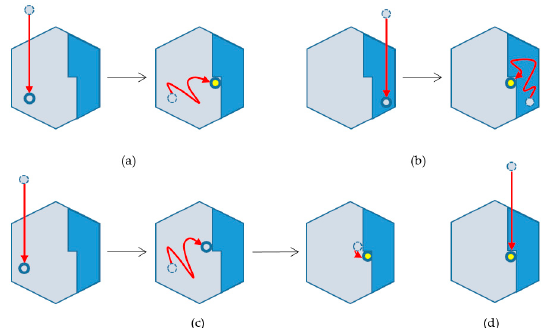
Figure 3. Schematic of the classification of particle incorporation processes into a kink site. Hexagons indicate crystals. Gray and indigo parts show the first (lower) and second (upper) layers, respectively. The borders between these layers are mono-particulate steps. Kinks on the steps indicate kink sites at which particles are finally incorporated into the crystal. Yellow circles represent the particles that are just incorporated into the crystal at the kink sites on the steps. ( a ) kink incorporation processes via surface diffusion on lower layers; ( b ) those via surface diffusion on upper layers; ( c ) those via surface diffusion on lower layers and adsorption to the particle at the edge of the kink site; ( d ) direct incorporation from the solution. Dashed and solid circles at both ends of arrows indicate particles at the previous and present positions, respectively.